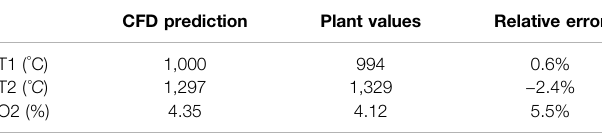
TABLE 3 | The comparison between CFD results and experimental plant values. CFD prediction Plant values Relative